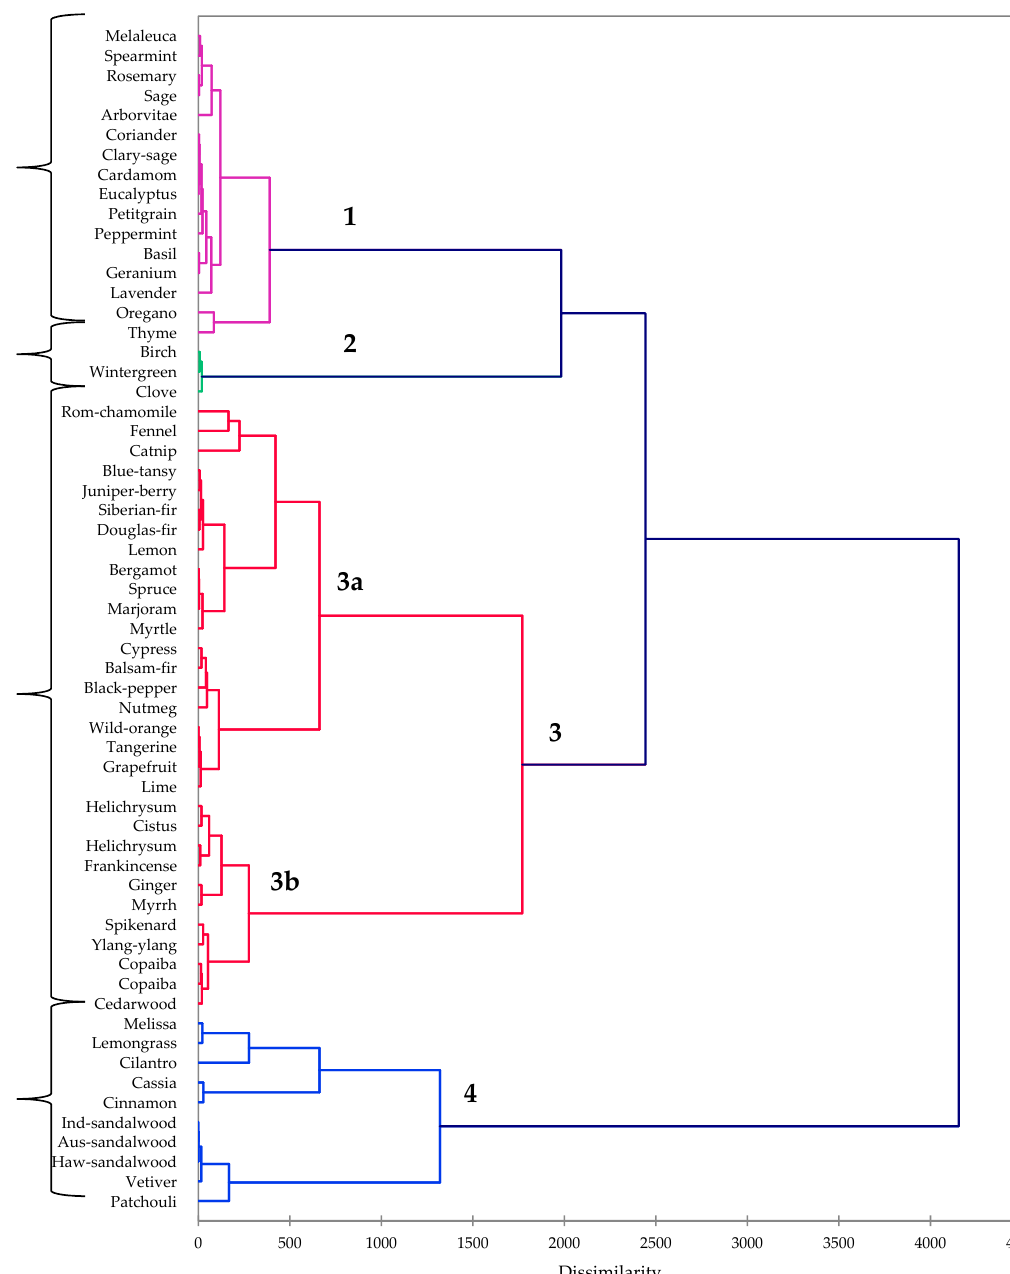
Figure 1. Dendrogram obtained from the agglomerative hierarchical cluster analysis of 60 essential oil compositions; antifungal and cytotoxic activities.